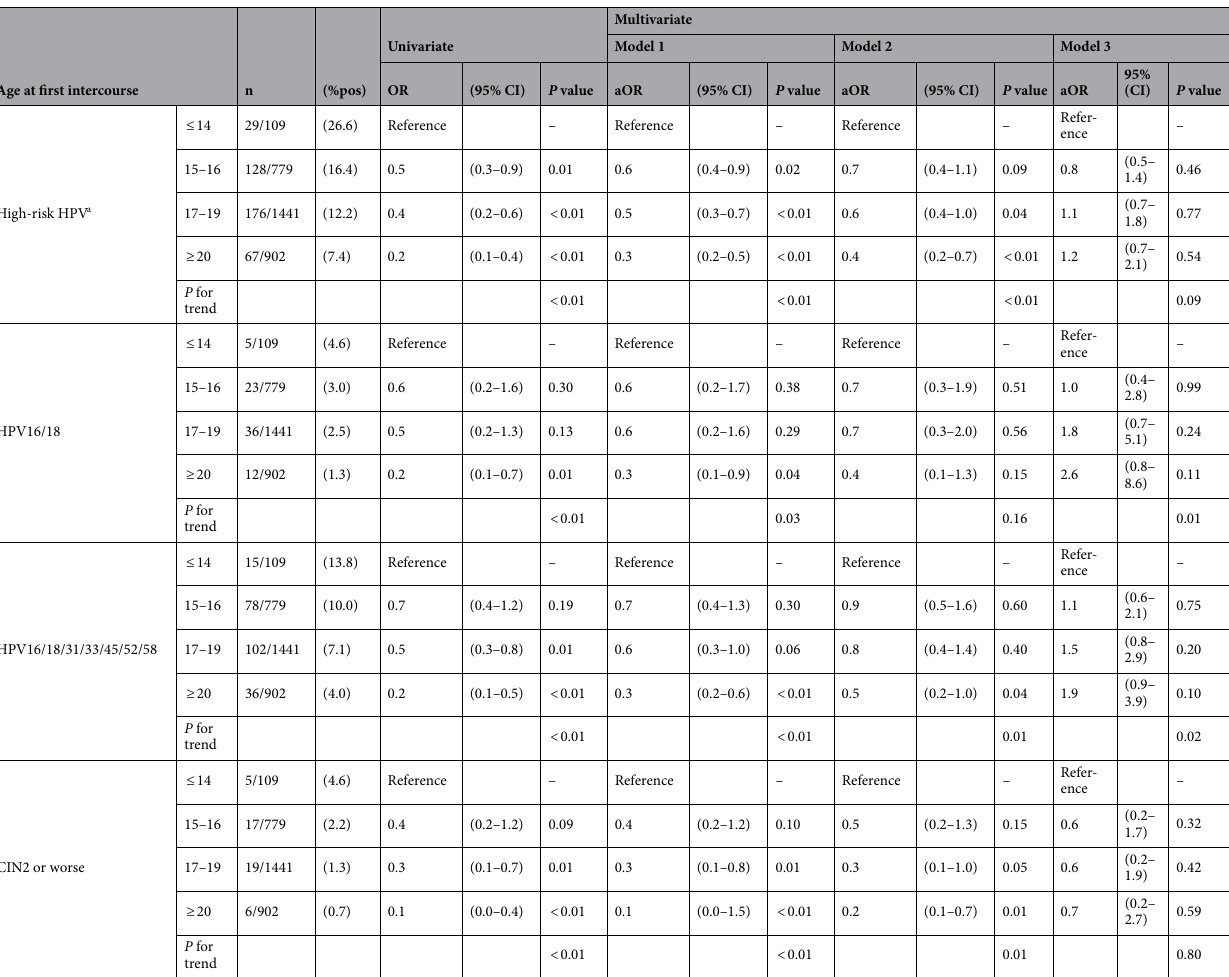
Table 3. Correlation between age at first intercourse rates of HPV infection and high-grade cervical disease (CIN2 or worse). CIN cervical intraepithelial neoplasia, OR odds ratio, aOR adjusted odds ratio. Model 1 adjusted for age. Model 2 adjusted for age and smoking history. Model 3 adjusted for age, smoking history and number of lifetime sexual partners. a HPV16/18/31/33/35/39/45/51/52/56/58/59/68